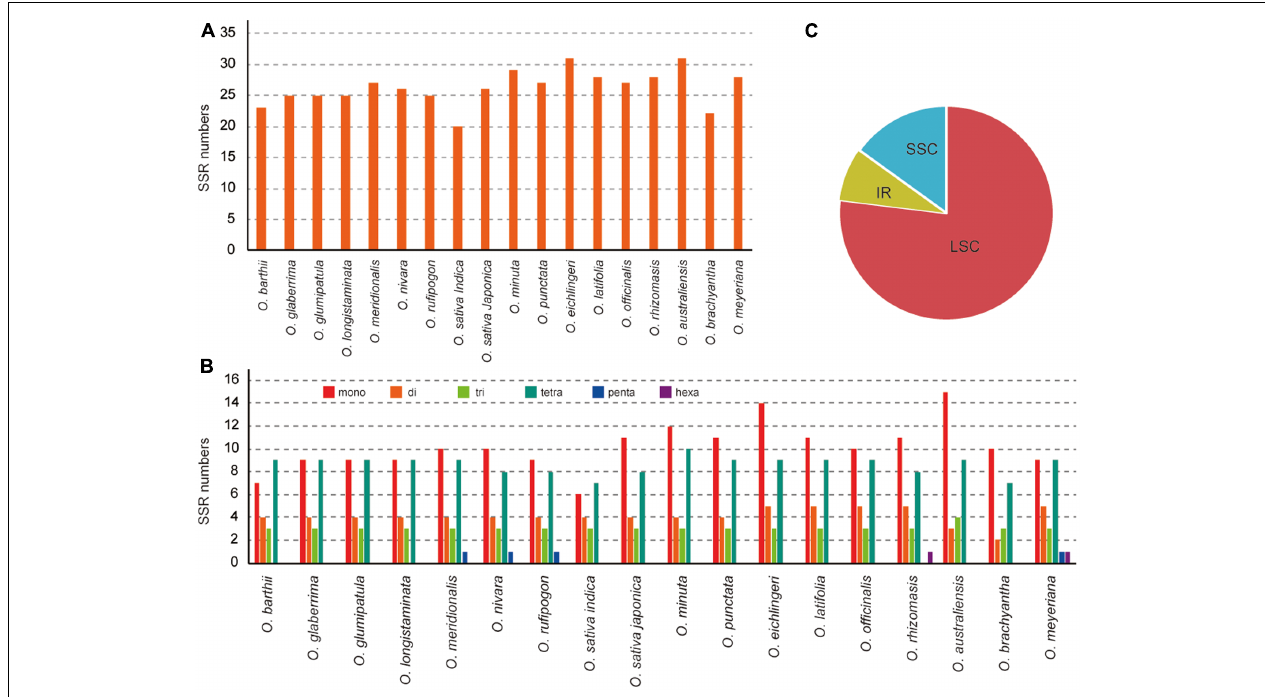
FIGURE 2 | Analysis of perfect simple sequence repeats (SSRs) in 18 Oryza chloroplast genomes. (A) Number of SSRs detected in 18 chloroplast genomes. (B) Frequency of identified SSRs in LSC, IR, and SSC regions. (C) Number of SSR types detected in 18 chloroplast genomes.